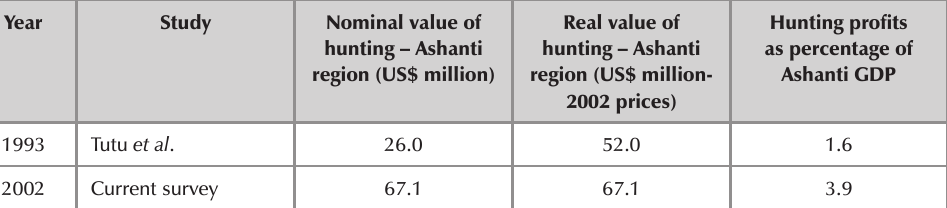
Contribution of hunting to Ashanti Gross Domestic Product